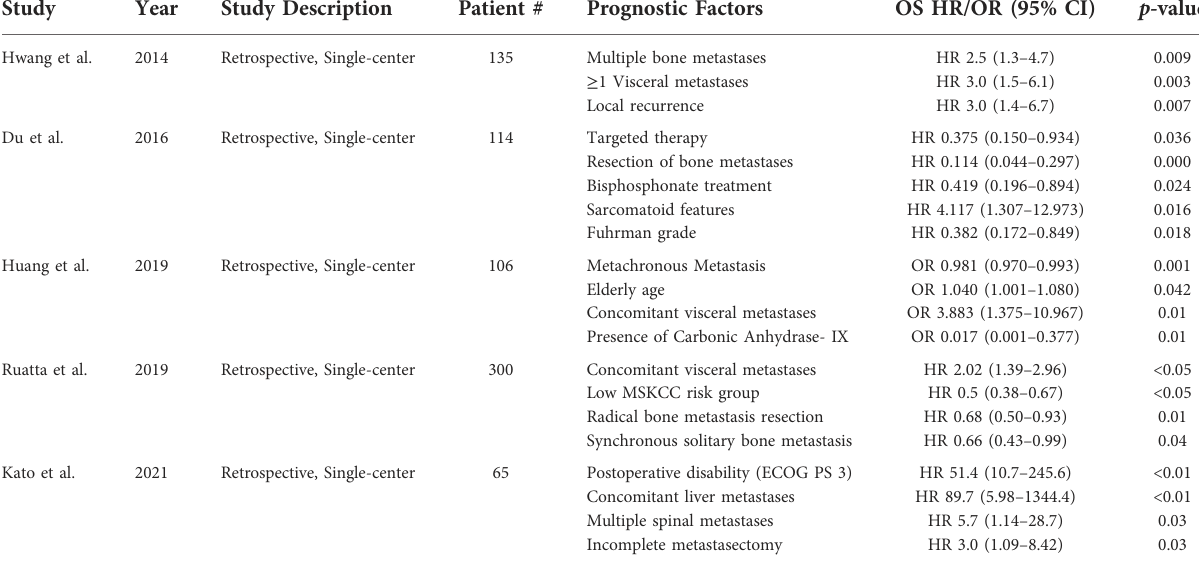
TABLE 3 Prognostic factors identi fi ed via multivariate analysis for metastatic renal cell carcinoma in patients with bone metastases.